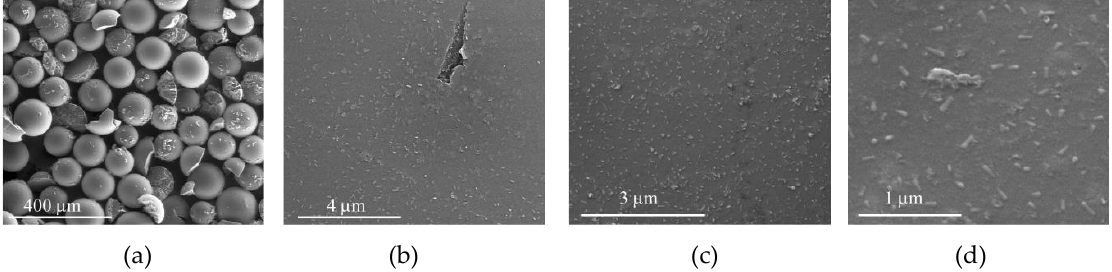
Figure 17. SEM micrographs of CAT-4-MR-TBHP after five cycles in oxidation reactions using TBHP as the oxidant. ( a ) 250×, ( b ) 25,000×, ( c ) 40,000×, ( d ) 100,000×.